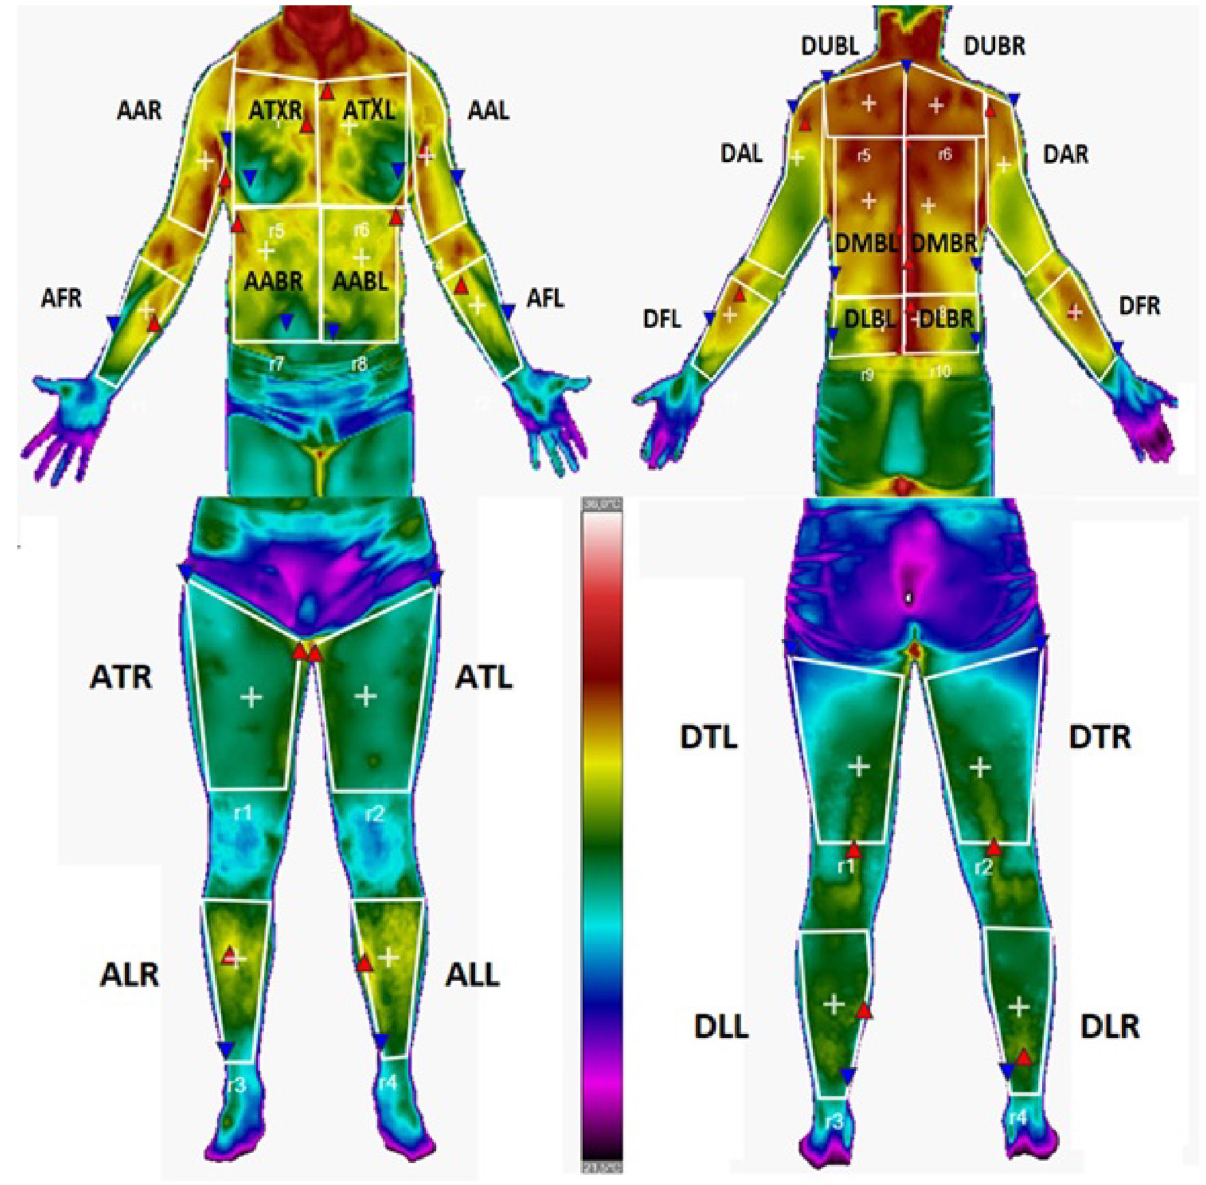
Figure 2 - Illustration of the Regions of interest in men, evaluated with infrared thermography. Legend: Anterior Forearm Right (AFR); Dorsal Forearm Right (DFR); Anterior Forearm Left (AFL); Dorsal Forearm Left (DFL); Anterior Arm Right (AAR); Dorsal Arm Right (DAR); Anterior Arm Left (AAL); Dorsal Arm Left (DAL); Anterior Thorax Right (ATXR); Dorsal Upper Back Right (DUBR); Anterior Thorax Left (ATXL); Dorsal Upper Back Left (DUBL); Anterior Abdomen Right (AABR); Dorsal Middle Back Right (DMBR); Anterior Abdomen Left (AABL); Dorsal Middle Back Left (DMBL); Dorsal Lower Back Right (DLBR); Dorsal Lower Back Left (DLBL); Anterior Thigh Right (ATR); Dorsal Thigh Right(DTR); Anterior Thigh Left(ATL); Dorsal Thigh Left (DTL); Anterior Leg Right (ALR); Dorsal Leg Right (DLR); Anterior Leg Left (ALL); and Dorsal Leg Left